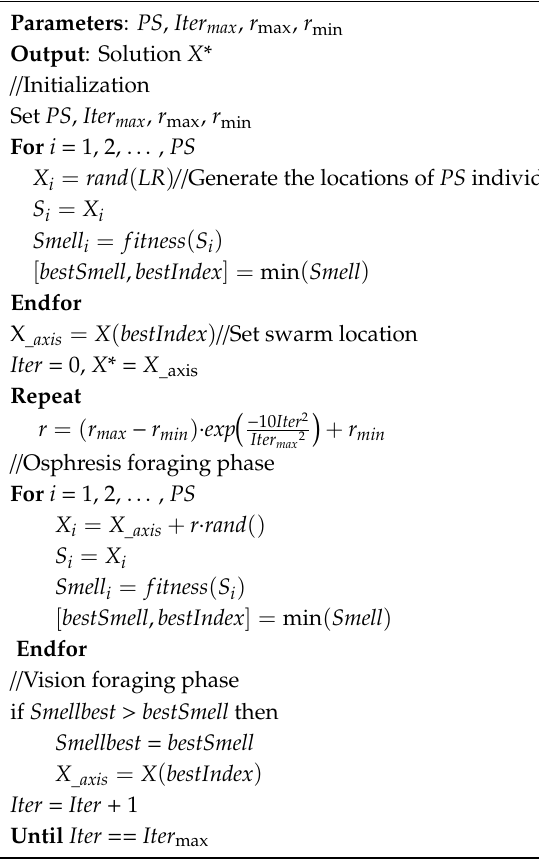
Algorithm 1 . Improved fruit fly optimization algorithm (IFOA) algorithm